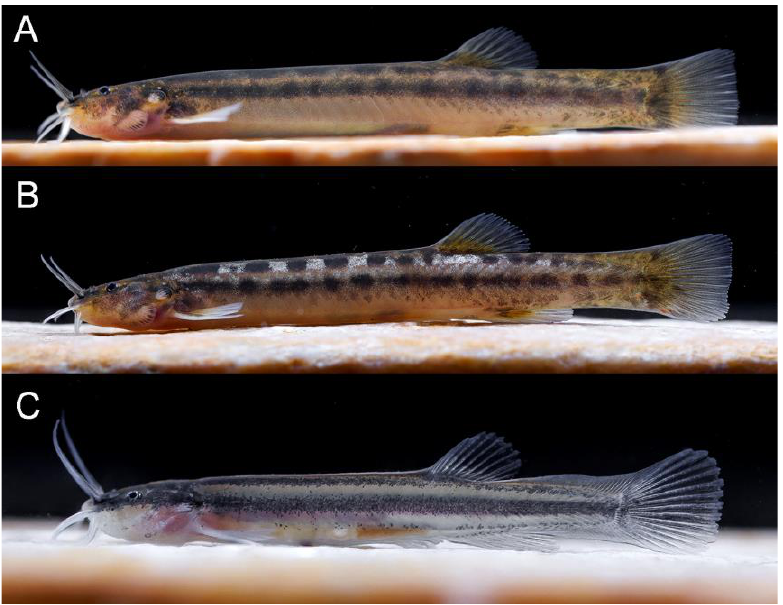
Figure 14. Live specimens of Trichomycterus saquarema Costa, Katz, Vilardo and Amorim, sp. nov. ( A ) UFRJ 13019, holotype, 53.1 mm SL; ( B ) UFRJ 13059, paratype, 45.8 mm SL; ( C ) UFRJ 13236, paratype, 13.9 mm SL.